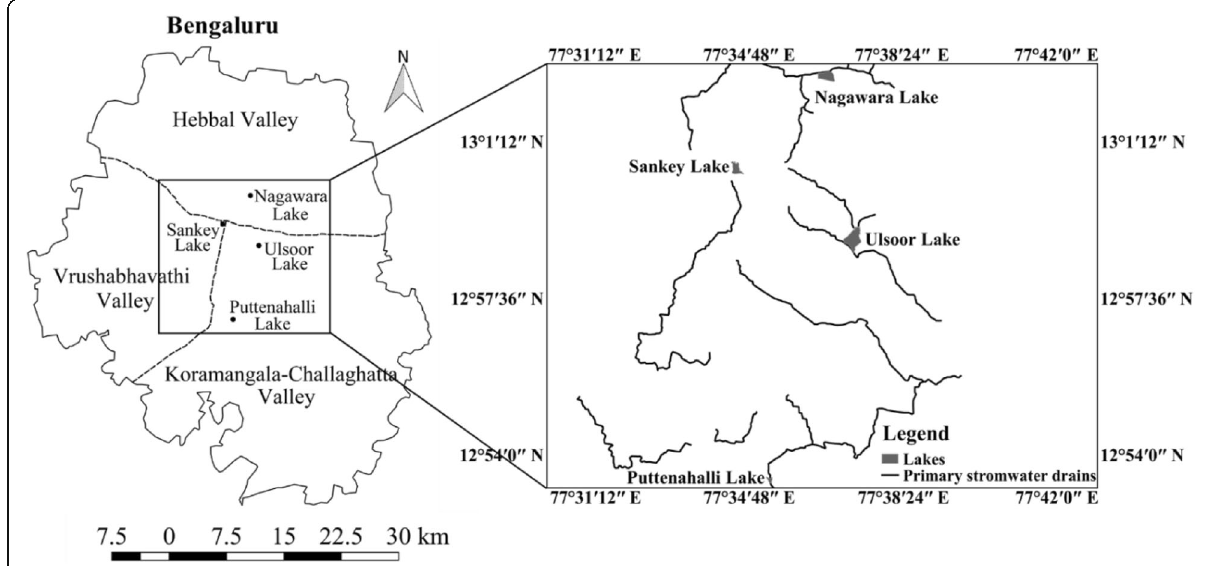
Fig. 1 Location map of valleys, lakes and primary stormwater